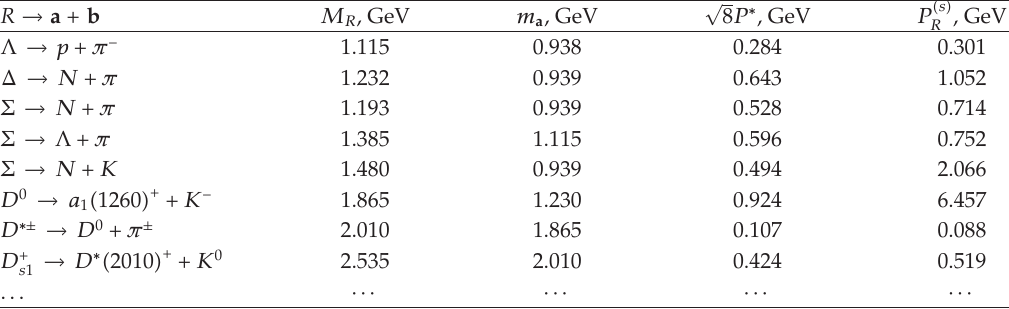
√ (cid:3) s (cid:4) M R 8 P ∗ and P R > P R . Here (cid:3) s (cid:4) m -bands separation (cid:3) 8 (cid:4) . R is the threshold momentum of the √ (cid:3) s (cid:4) 8 P ∗ , GeV P R , GeV a , GeV